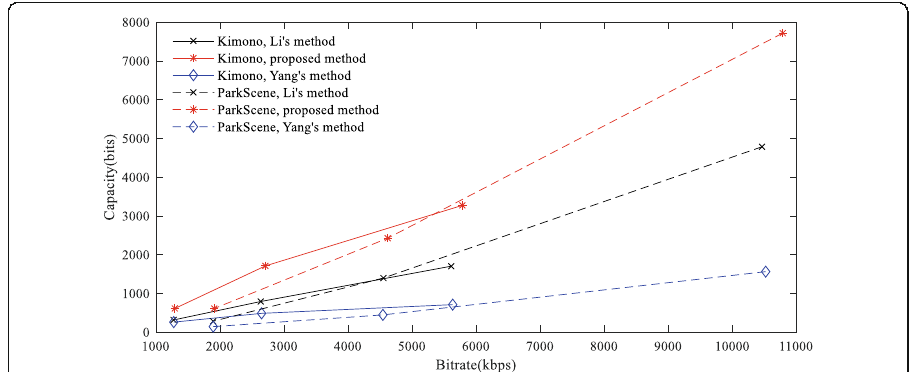
Fig. 7 Comparison of RC with Li ’ s method and Yang ’ s method for sequences Kimino and ParkScene